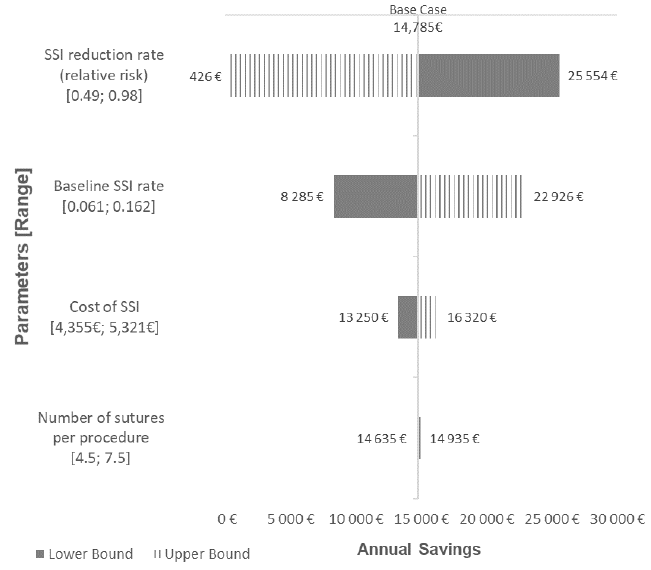
Figure 1. Tornado diagram with one-way sensitivity analysis results. Abbreviations: SSI, surgical site infection.